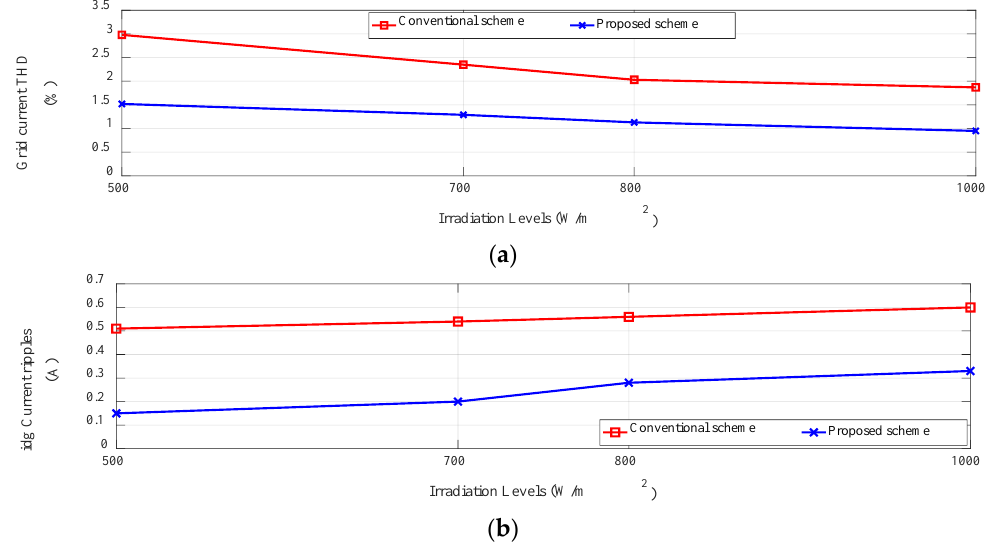
Figure 17. Comparison of: ( a ) grid current THD%; ( b ) grid current ripples; under irradiation changes.